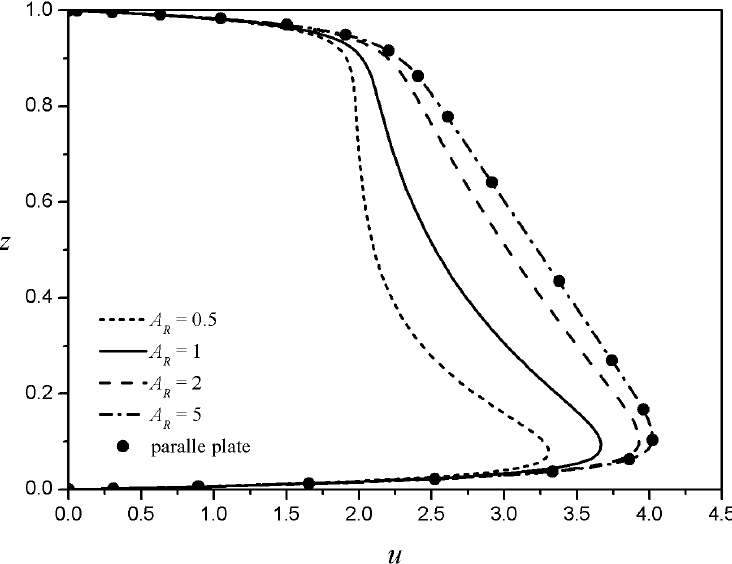
, , and . 𝐿𝐿 𝐷𝐷 = 0.03 𝑍𝑍 𝑅𝑅 = 2 𝑛𝑛 = 0.8